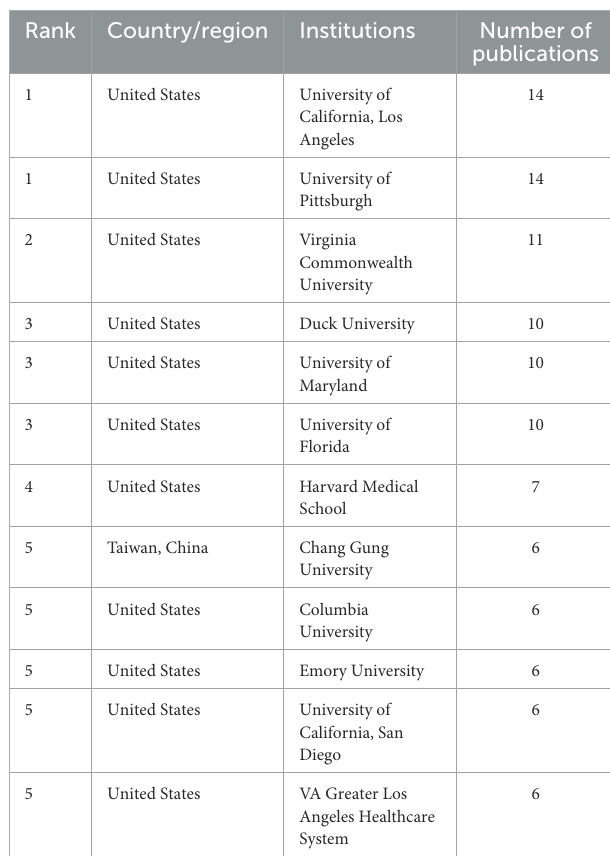
TABLE 4 Top 10 institutions in terms of number of articles